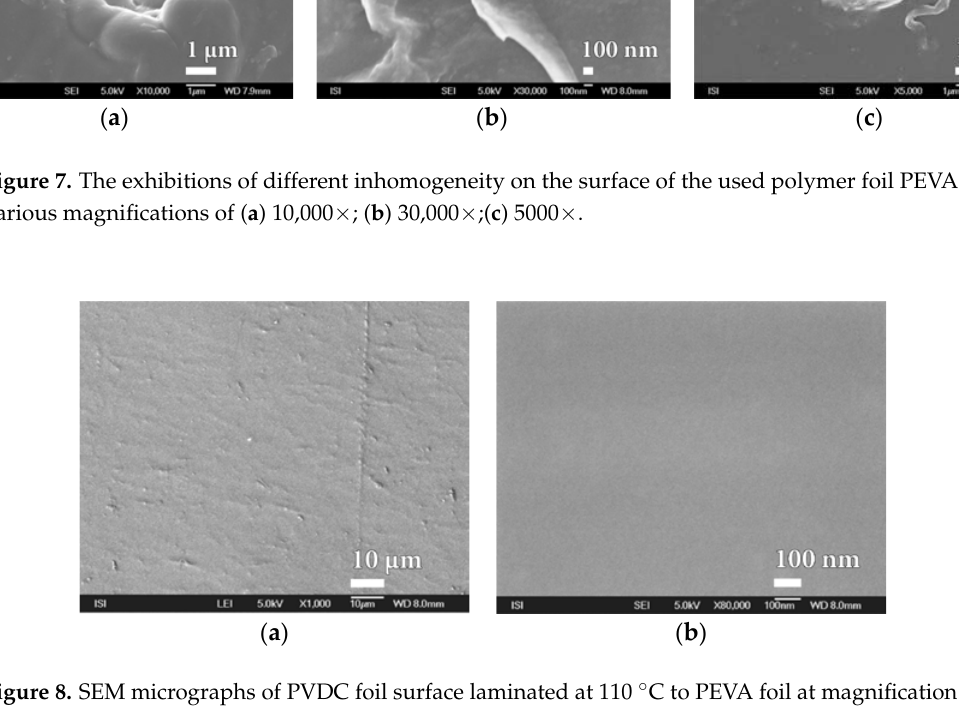
Figure 8. SEM micrographs of PVDC foil surface laminated at 110 °C to PEVA foil at magnification of ( a ) 1000× and ( b ) 80,000×.